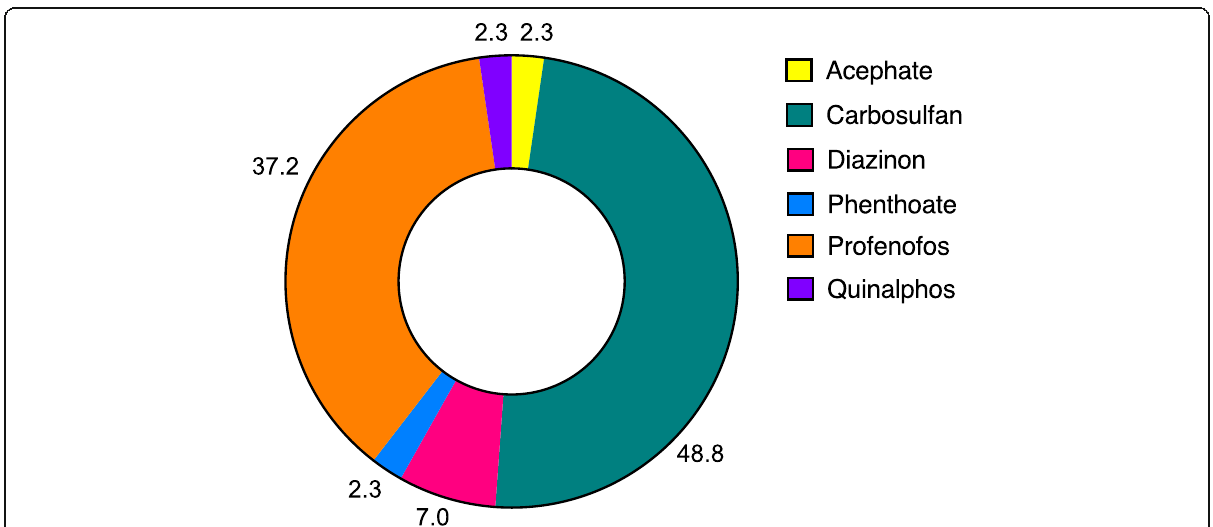
Fig. 2 Acetylcholinesterase inhibitor insecticides used in self-poisoning among adult males from July to December 2017 by percentage,